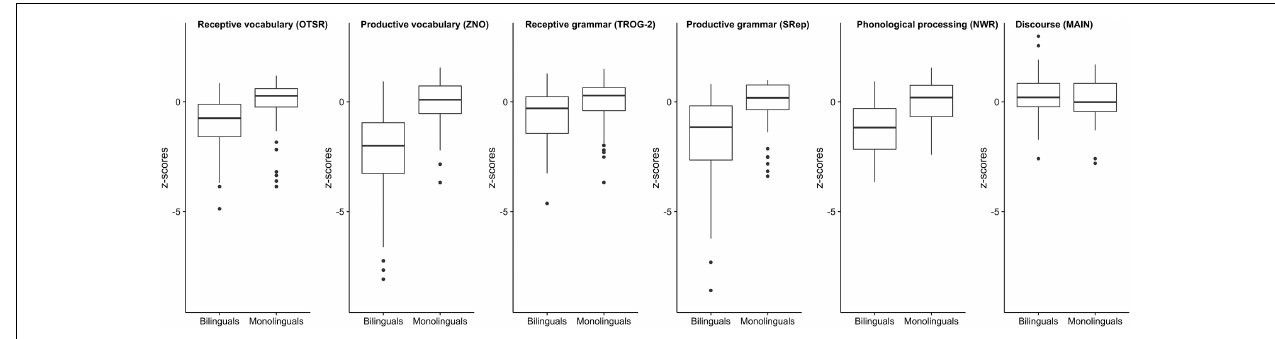
FIGURE 2 | The average performance (in z-scores) of bilingual and monolingual groups in each language task. The z-scores were calculated on the basis of the mean and standard deviation of the monolingual group in each task.